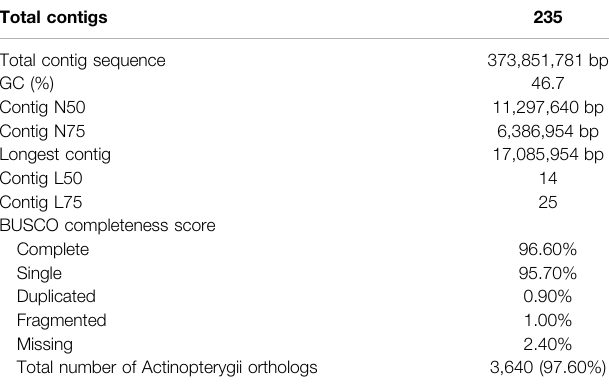
TABLE 2 | Polished genome assembly statistics and